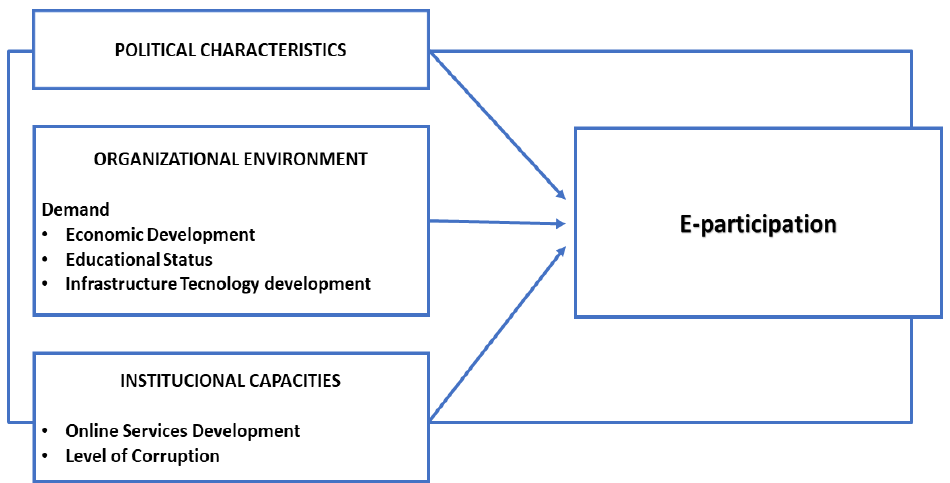
Figure 1. E-participation